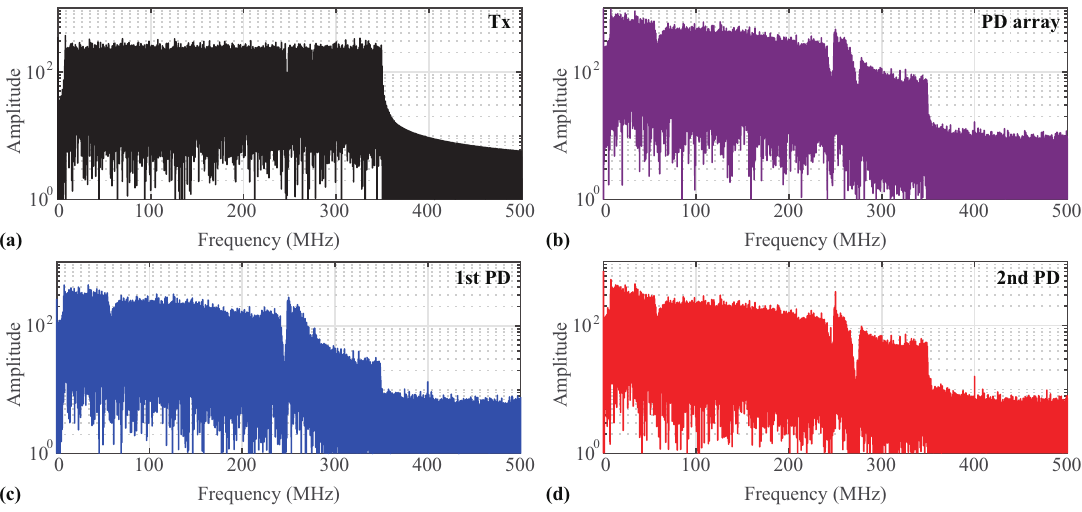
Figure 4. The spectrum of ( a ) the transmitted signal, ( b ) the received signal after MRC algorithm, ( c ) the received signal with only light 1 on, and ( d ) the received signal with only light 2